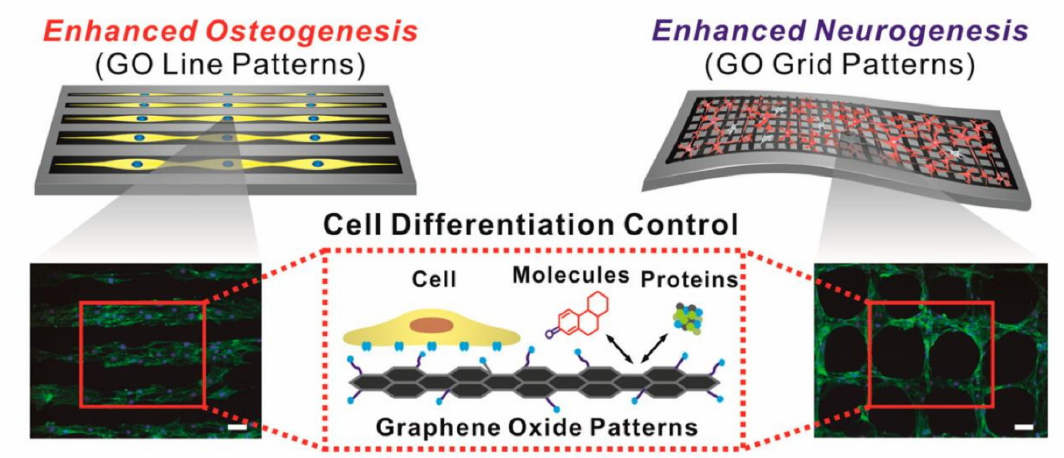
Figure 5. E ff ects of GO micropatterns on stem-cell di ff erentiation. Enhancement of osteogenic and neuronal di ff erentiation, using microcontact-printed GO substrate with line and grid patterns. Fluorescence image of stem cells stained with F-actin. Scale bar = 100 µ m. Reprinted with permission from Kim et al.